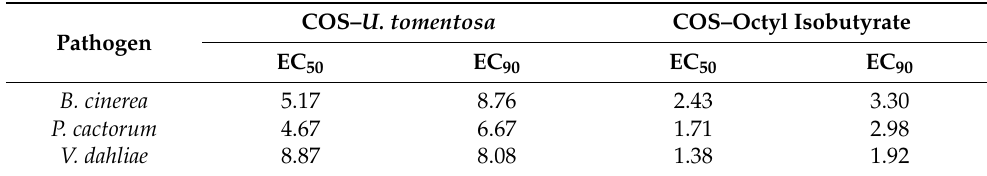
Table 3. Synergy factors for the conjugate complexes estimated according to Wadley’s